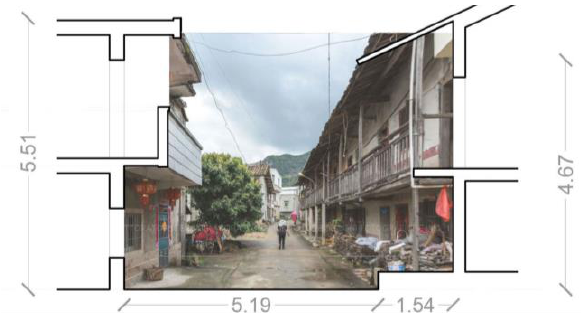
Figure 5. Urban sections showing the consistency of the built form.